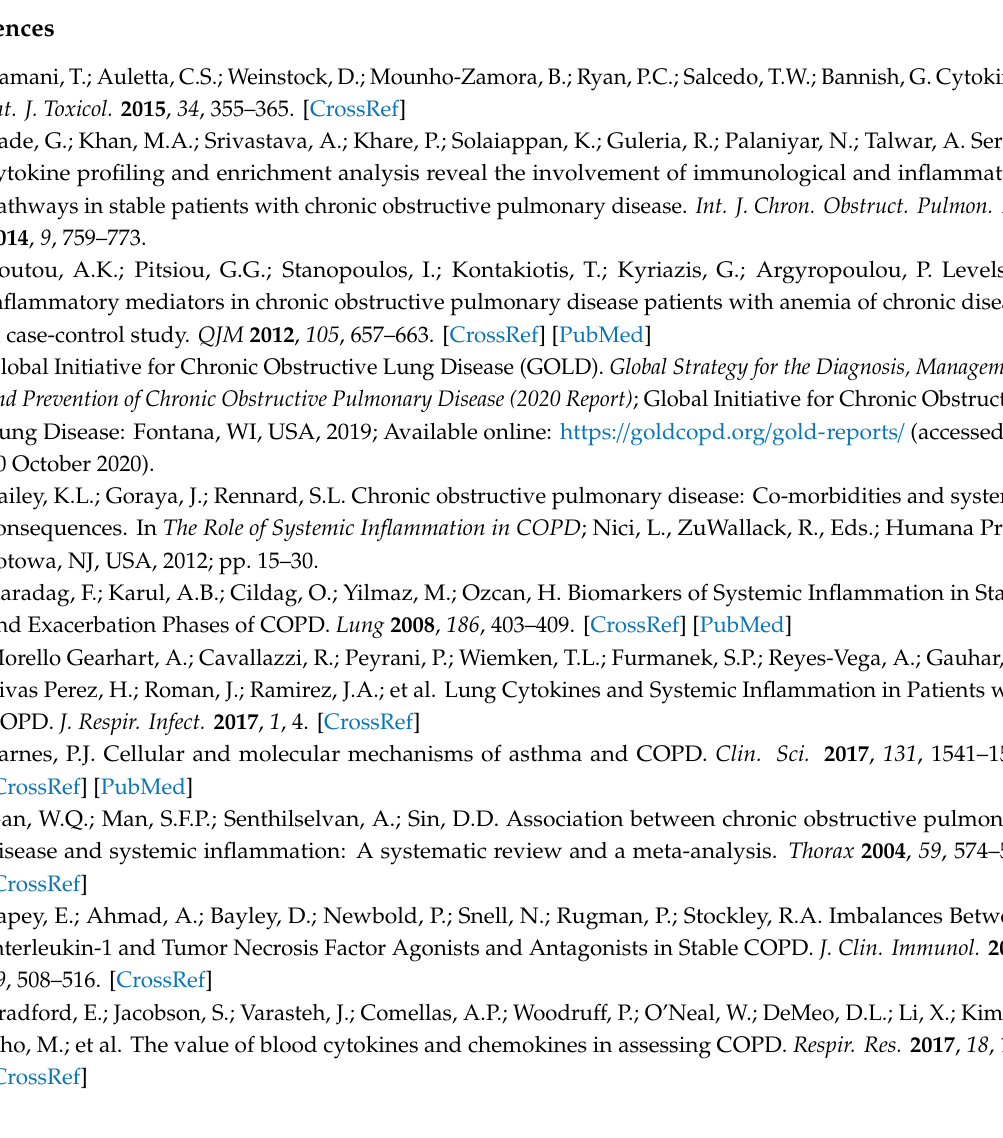
Table S1: Levels of cytokines in all participants regarding their smoking status, Table S2: Values of 95th percentile of the parameters determined in healthy non-smokers that are used in network analyses, Table S3: Clinical characteristics and concentrations of cytokines (IL-1 β , IL-6, TNF α ), common inflammatory parameters (CRP, Fbg) and DAMPs (eATP, eHsp70) in COPD patients according to the five clusters after unsupervised hierarchical clustering